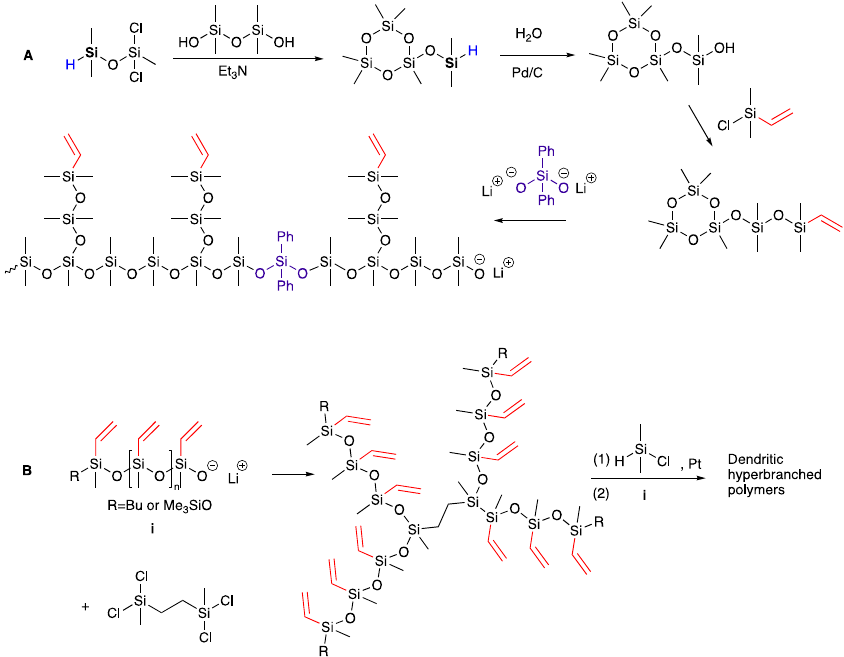
Figure 1. ( A ) The synthesis of hyperbranched polysiloxane using anionic ring-opening polymeri- zations [19]; ( B ) The synthesis of dendrite-branched polysiloxanes